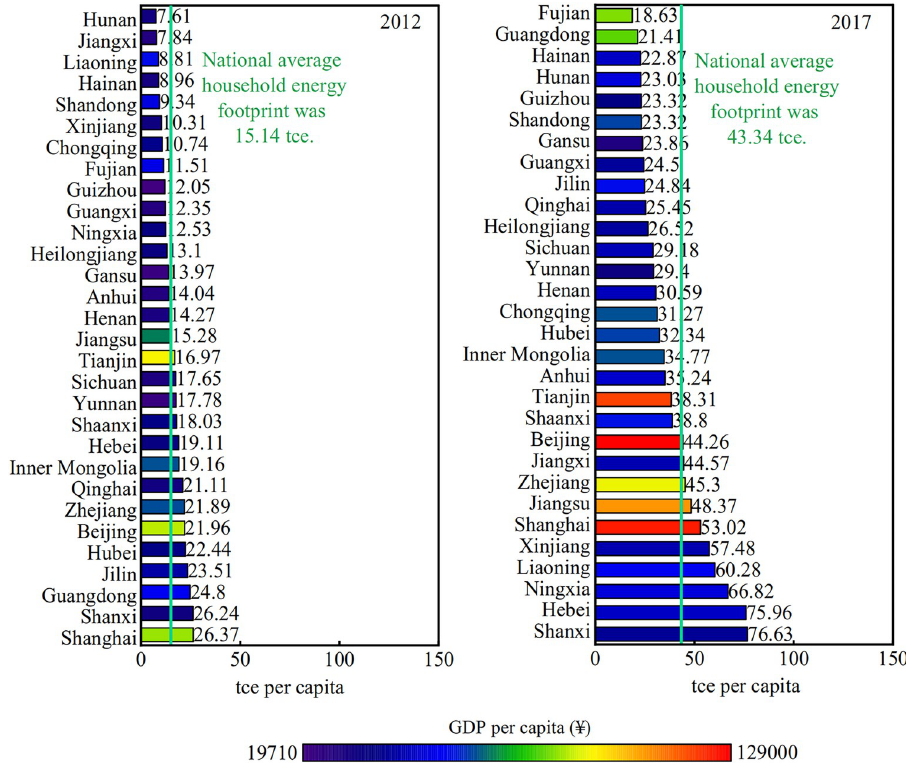
Fig 1. The PCHEF of 30 provinces in China in 2012 and 2017. The colors of these numerical bars correspond to provincial GDP per capita, ranging from red for the richest province to blue for the poorest.